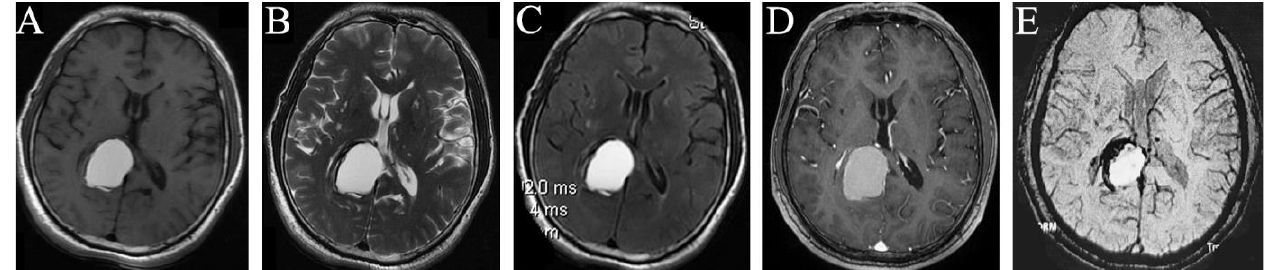
Figure 2. MRI manifestations of the space-occupying intracranial fungal lesion on 9 July 2020. T1WI ( A ), T2WI ( B ), T2 Flair ( C ), and Contrast-enhanced T1 ( D ) show that the right occipital lobe occupa- tion became obviously larger than before, with predominantly high signals on T1WI ( A ), T2WI ( B ), and T2 Flair ( C ), and equally enhanced signal on Contrast-enhanced T1 ( D ); SWI examination found no vascular diseases ( E ).